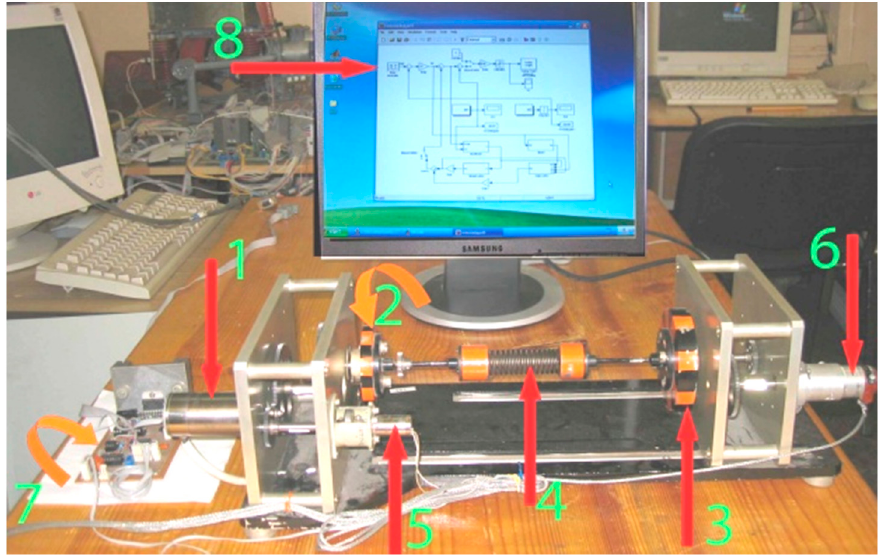
Figure 3. The experimental system of the drive with the elastic coupling.